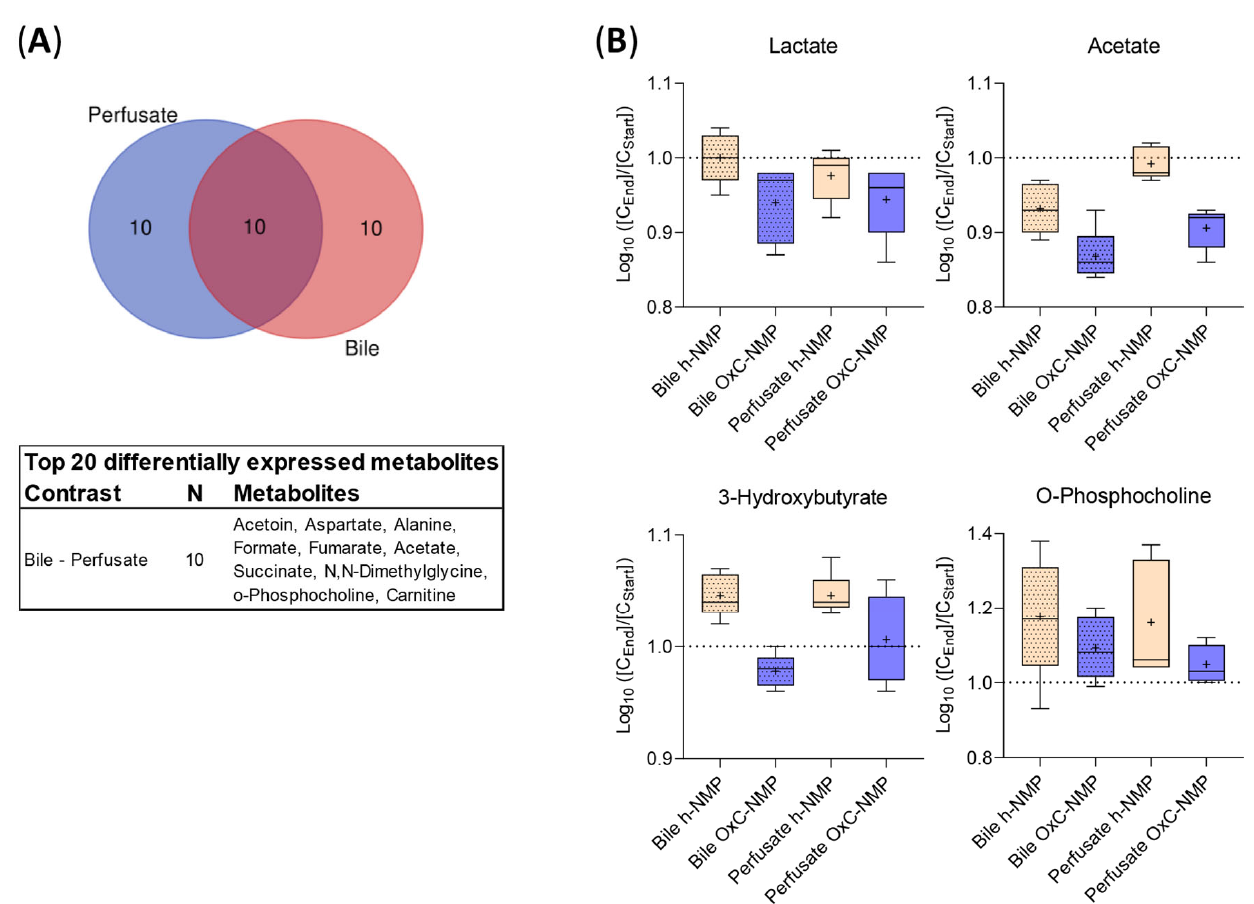
Figure 5. Comparison between metabolite concentrations in bile and perfusate samples. ( A ) Venn diagram and corresponding table showing the top 20 differentially expressed metabolites in either perfusate or bile samples and their distribution across the analyzed samples. ( B ) Normalized concentration ratio [C End ]/[C Start ] to logarithmic scale (log10) of metabolite increase (above 1.0 dashed line) or decrease (below 1.0 dashed line) during the perfusion in bile (dotted) and perfusate (clear) at 1 h (yellow) and at the end of NMP (blue), illustrated as bar plots with Tukey’s whiskers; line indicates the median, plus indicates the mean.